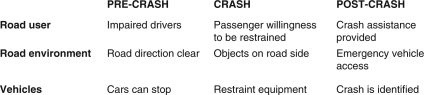
Haddon Matrix with sample injury factors (adapted from Haddon14).